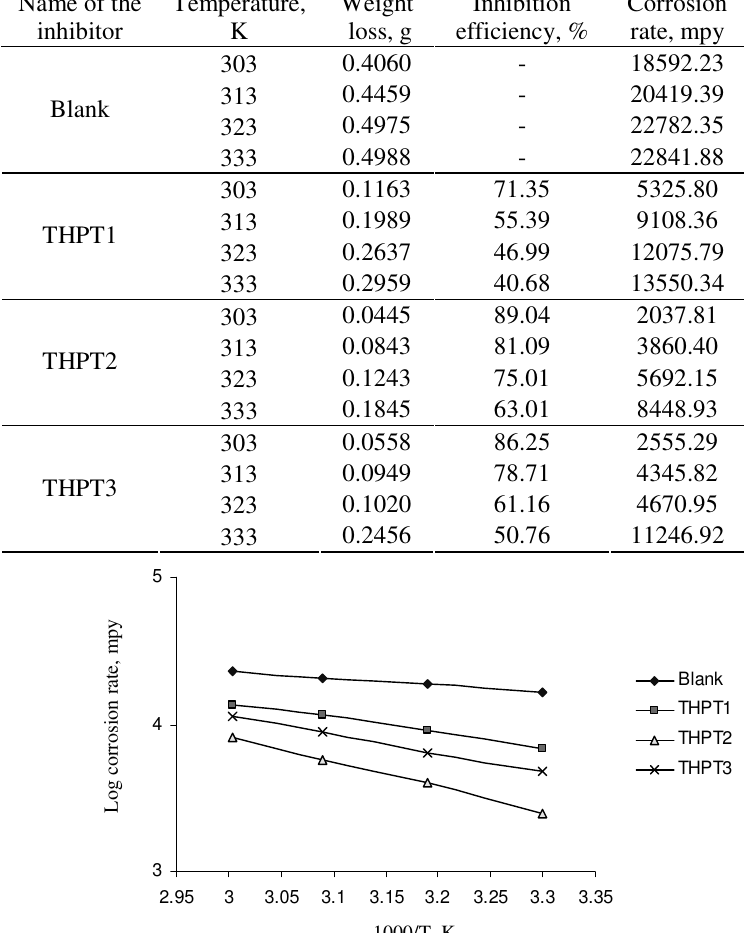
Figure 2. Arrhenius plot of corrosion rate of mild steel in 1 M H absence and presence of